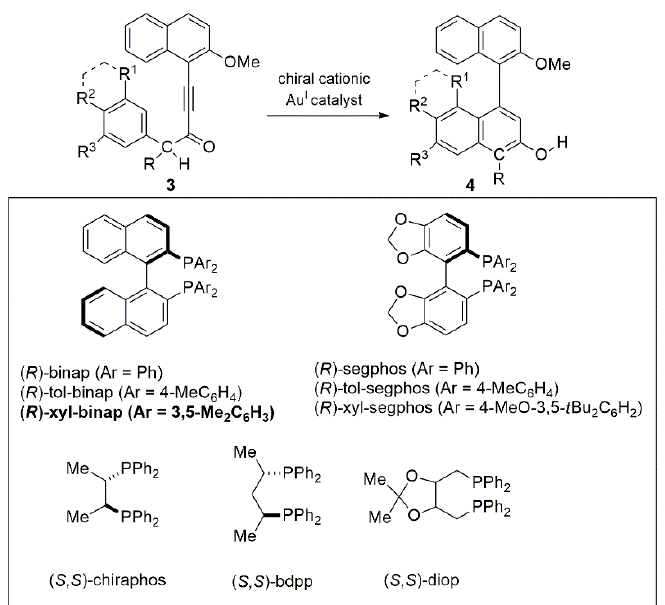
Figure 3. Gold-catalyzed intramolecular hydroarylation of alkynones ( 3 ) for the atroposelective syn- thesis of axially chiral biaryl derivatives ( 4 ).